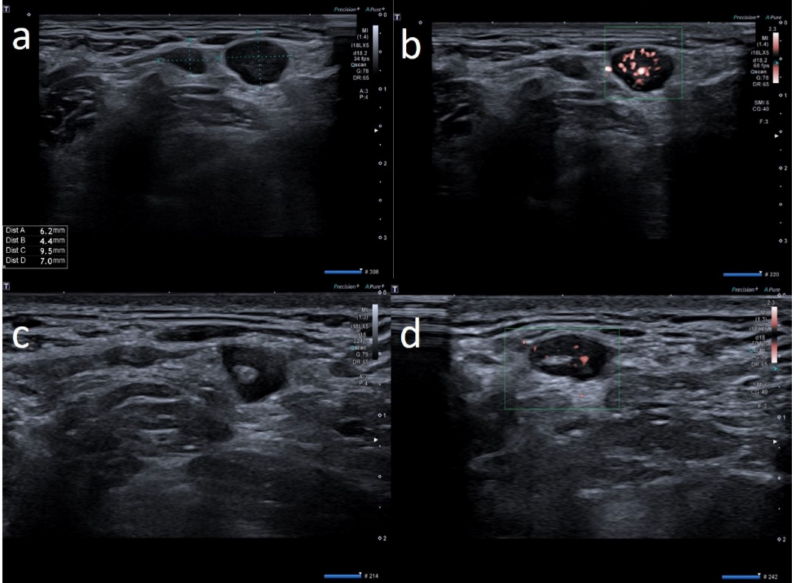
Figure 2. 28-year-old female with palpable unilateral sopraclavicolar adenopathy noted 3 days after receiving the first dose of the AstraZeneca COVID-19 vaccine in her left deltoid muscle. ( a ) B-mode sonogram image shows 2 round hypoechoic lymph nodes with hilum absence. ( b ) SMI images show central and peripheral vascularization. ( c ) After 2 weeks, sonogram image shows the restoration of normal pattern of the smaller lymph node whereas the other node presents asymmetric cortical thickening but with hilum reappearance. ( d ) After 1 month, the cortical thickening appears uniform, with hilum evidence and normal